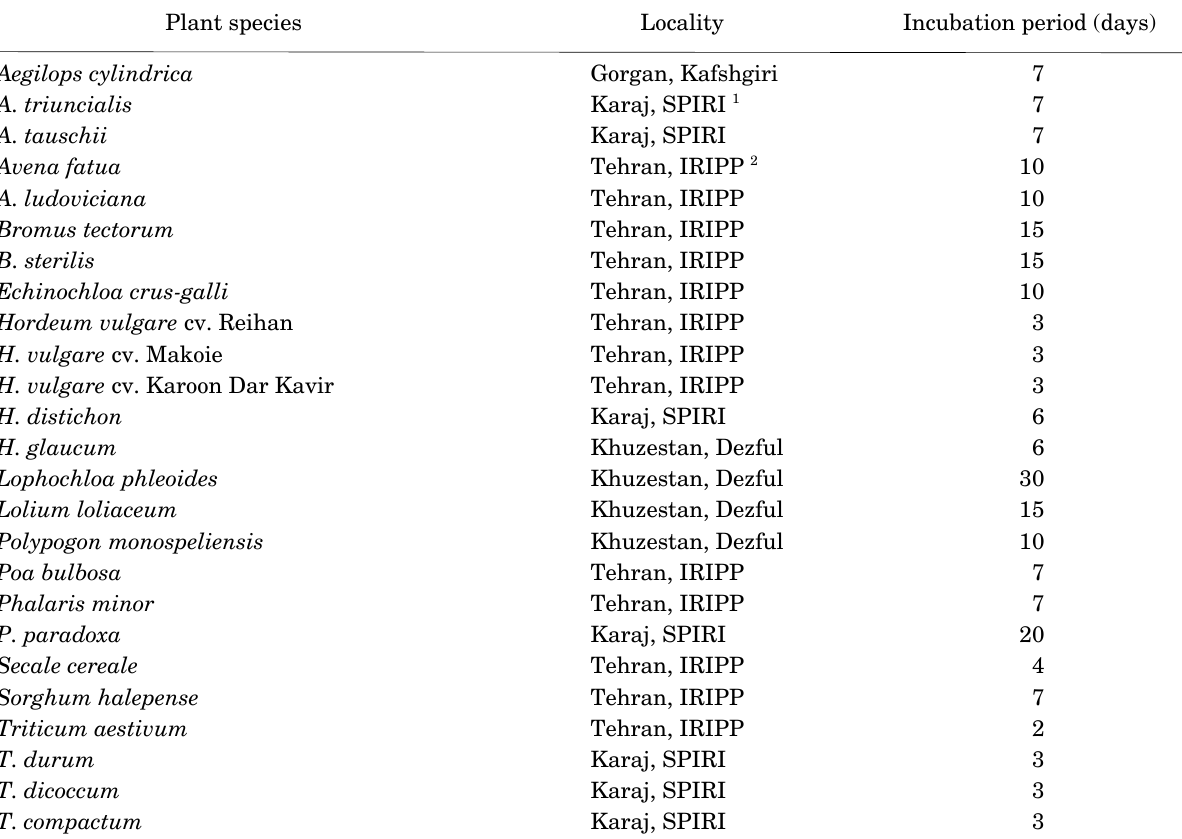
Table 2. List of cereals and wild grasses used to determine the host range of Septoria species and incubation period in the solutions used for breaking seed